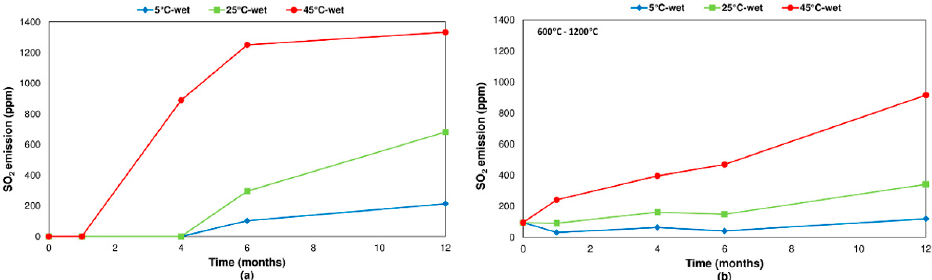
Figure 9. Sulfur dioxide emission area of pyrite (the fine fraction) ( a ) in the range 600–900 ◦ C and a wet environment and ( b ) in the range 900–1200 ◦ C and a wet environment .